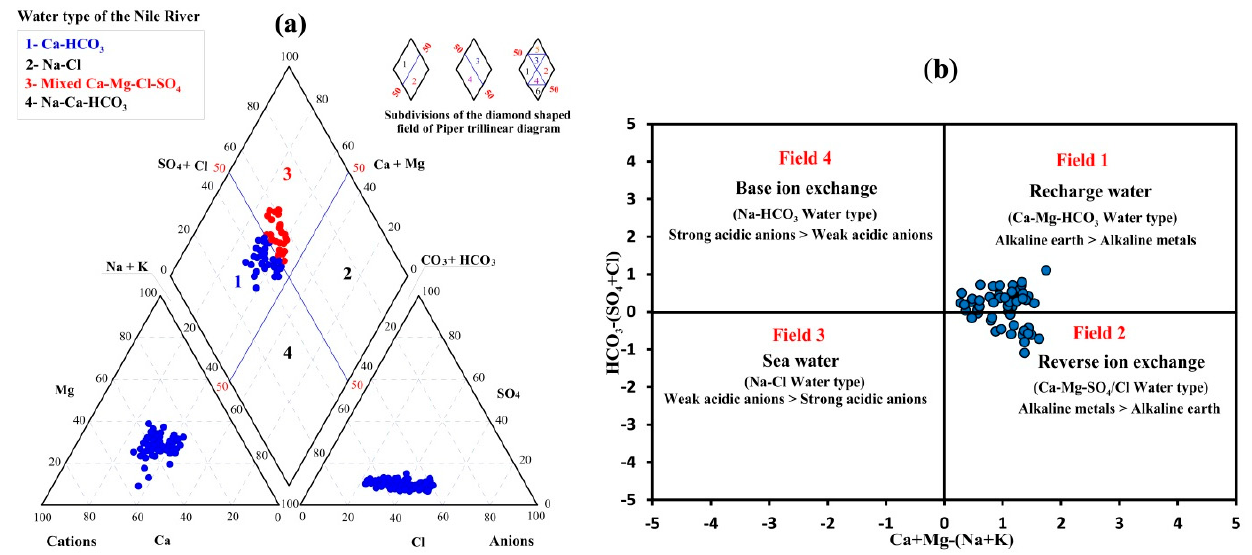
Figure 4. Surface water type and geochemical processes in the Nile River: ( a ) Piper diagram and ( b ) Chadha diagram.